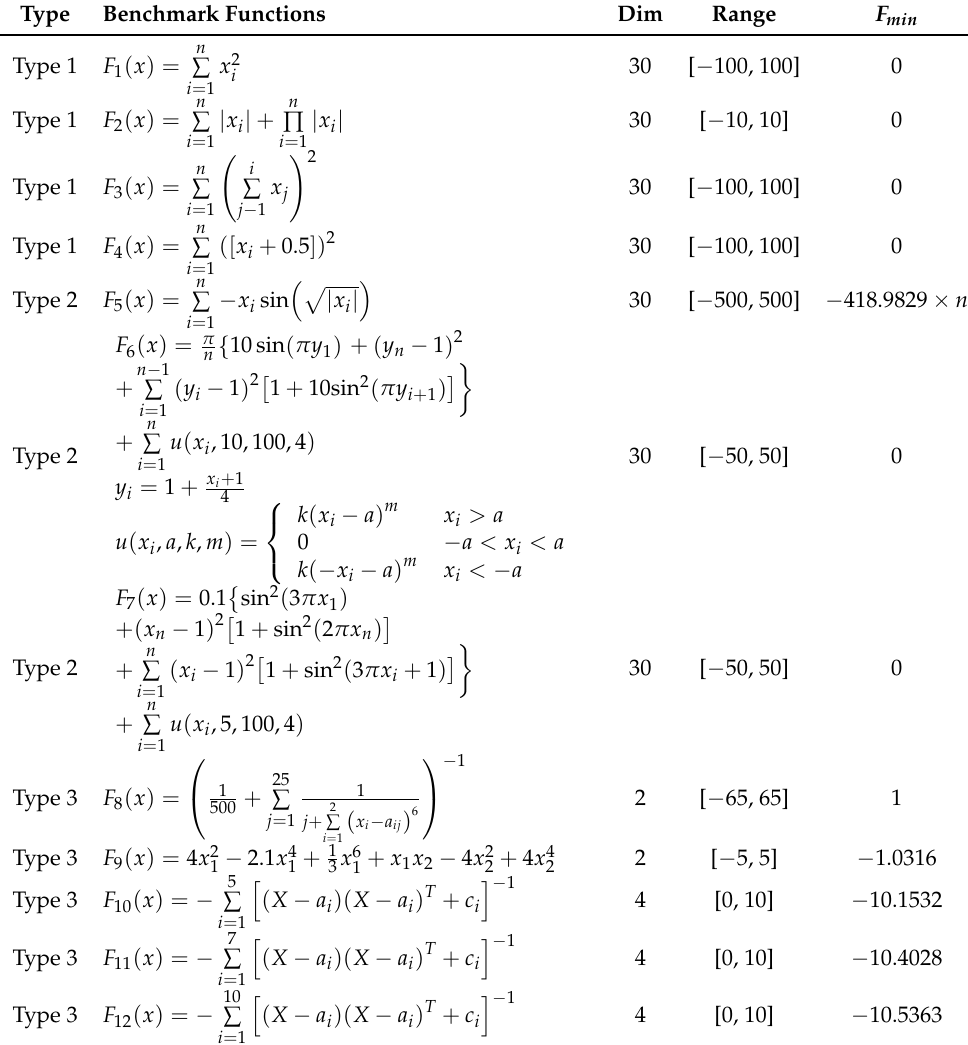
Table 2. Benchmark test